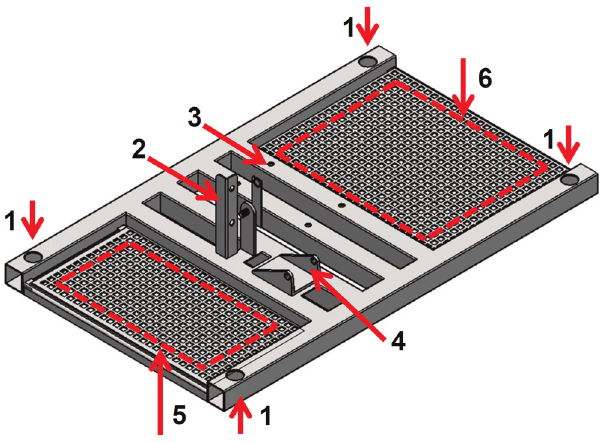
Fig. 4. Support frame of the range extender: 1 – hole for mounting of damping elements, 2 – bracket of a rectifier bridge, 3 – hole for mounting